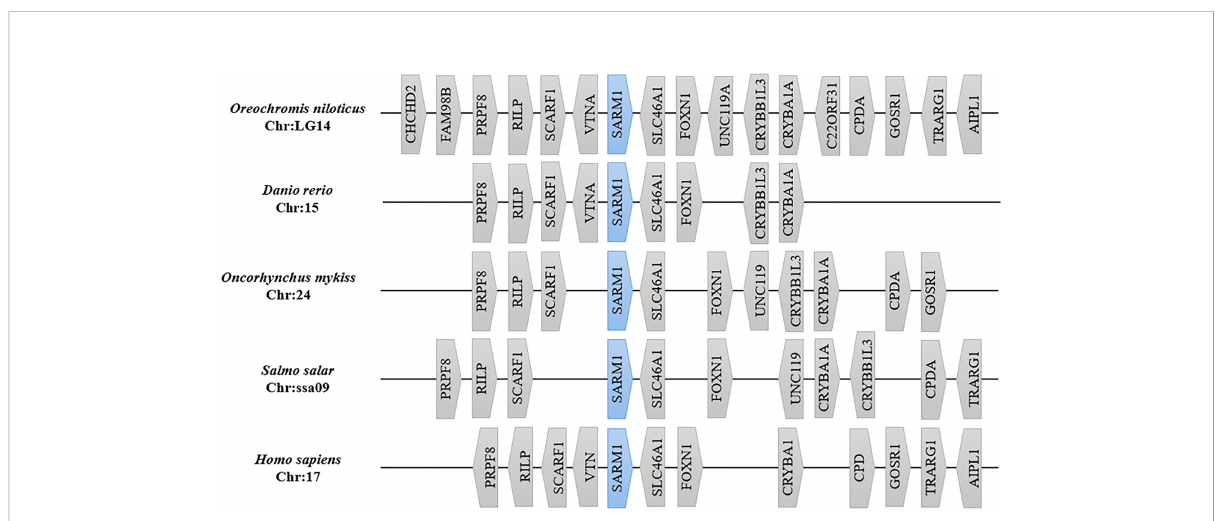
FIGURE 4 Gene synteny analysis of segments containing SARM1 from different species. Gene order on the chromosome of each species was collected using the Genomicus database (Version 100.01). Gene distance was not drawn to scale. Gene names are given as follows: CHCHD2, Coiled- coil-helix-coiled-coil-helix domain containing 2; FAM98B, Family With Sequence Similarity 98 Member B; PRPF8, Pre-mRNA-processing- splicing factor 8; RILP, Rab-interacting lysosomal protein; SCARF1, Scavenger Receptor Class F Member 1; VTNA, vitronectin a; SARM1, Sterile alpha and TIR motif-containing protein 1; SLC46A1, Solute Carrier Family 46 Member 1; FOXN1, Forkhead box protein N1; UNC119A, Protein unc-119 homolog A; CRYBB1L3, crystallin beta B1d; CRYBA1A, Beta A1-crystalline; C22ORF31, chromosome 22, open reading frame 31; CPDA, 3 ’ ,5 ’ -cyclic adenosine monophosphate phosphodiesterase; GOSR1, Golgi SNAP receptor complex member 1; TRARG1, Traf fi cking regulator of GLUT4 1; AIPL1, Aryl-hydrocarbon-interacting protein-like 1; UNC119, Uncoordinated-119; VTN, Vitronectin; CRYBA1, Crystallin Beta A1; and CPD, Carboxypeptidase